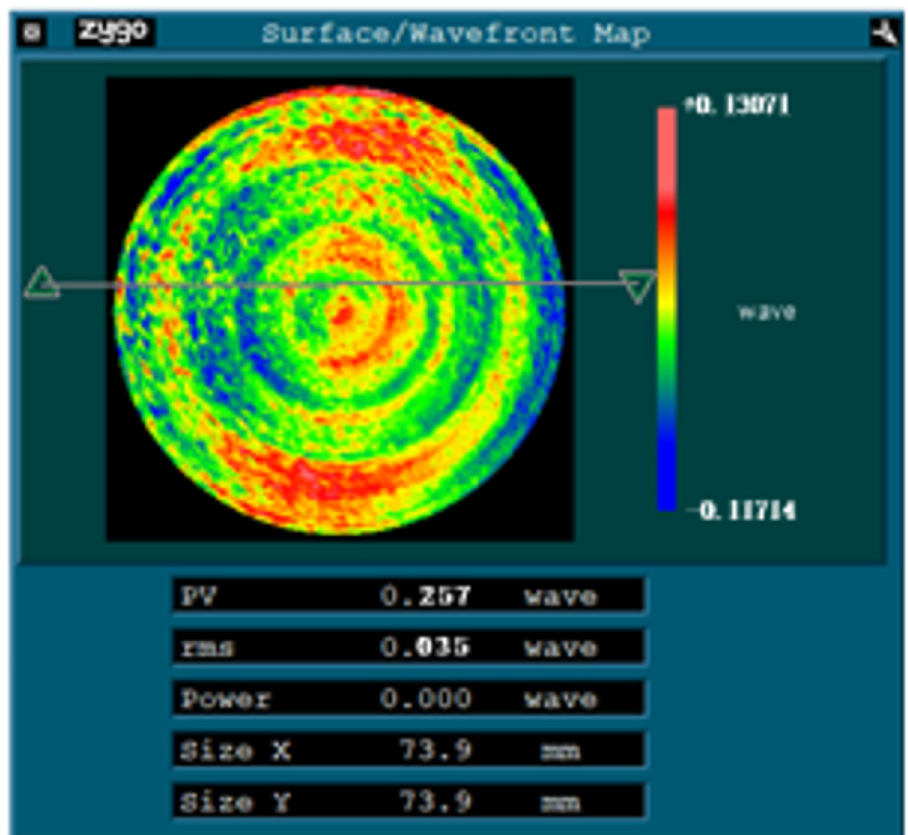
Fig 13. The result of second compensation